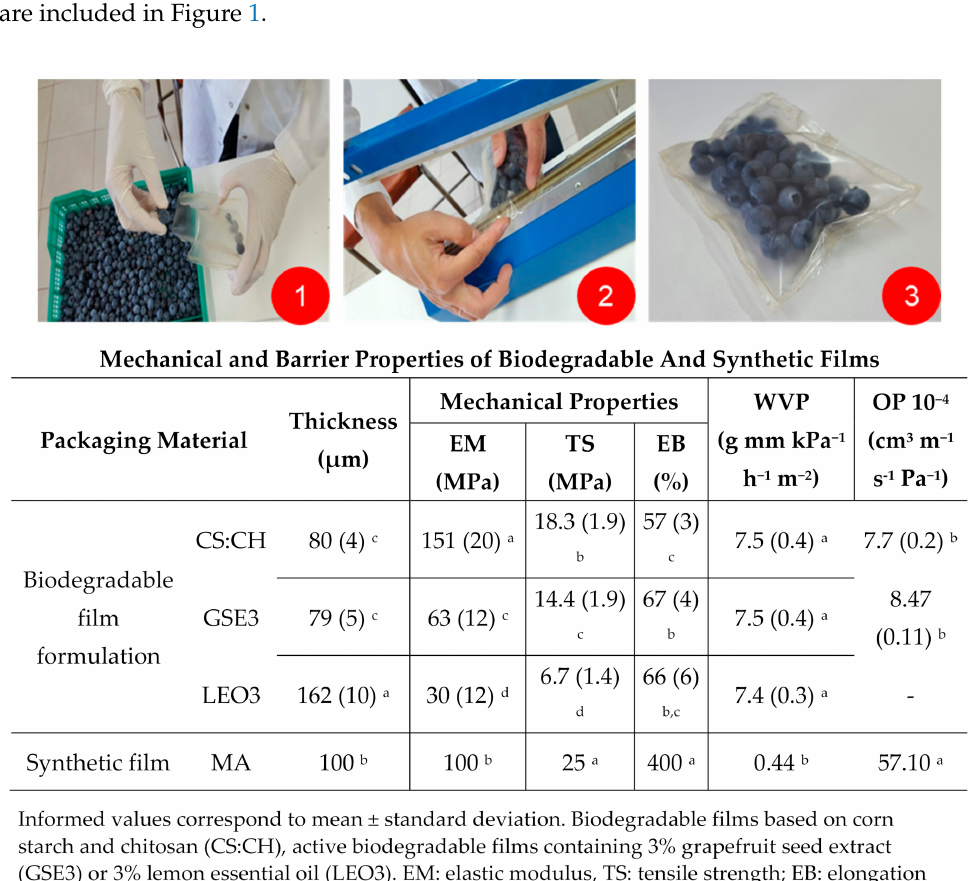
Figure 1. Blueberries packaging procedure using biodegradable active films and their relevant